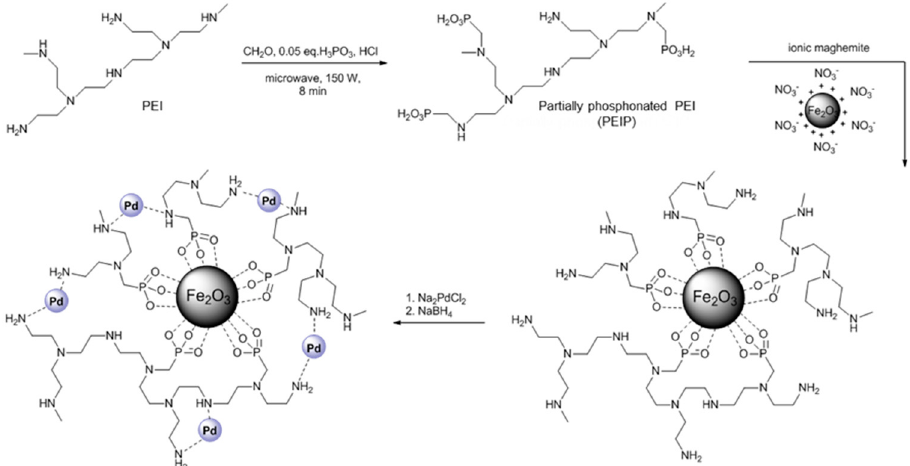
Figure 1. Number of methylphosphonates introduced on the PEI is under control. Only 0.05 equivalent of phosphorous are added compared to the number of amines, N-H bonds are therefore available for palladium complexation. The palladium immobilization on PEIP-coated nanoparticles is carried out in two steps: after coupling PdCl 2 on the free amino groups, the active species Pd (0) is obtained by reduction with sodium borohydride.